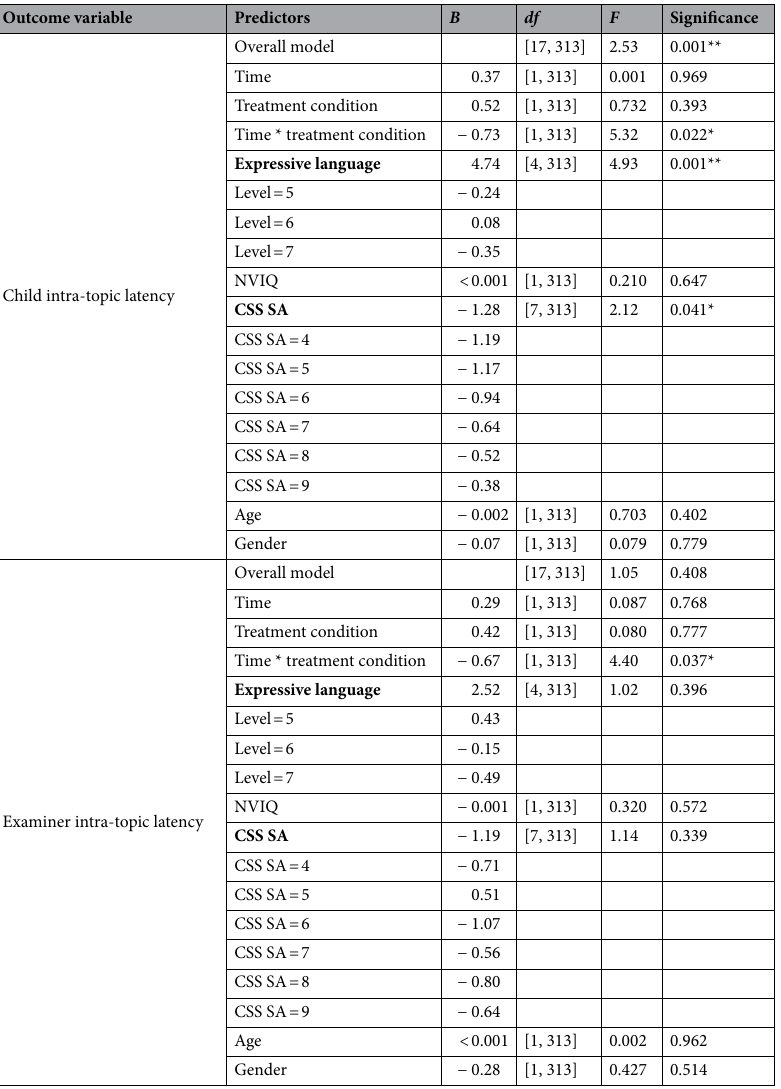
Table 2. Generalized linear mixed models of time and treatment effects for intra-topic latency. NVIQ nonverbal IQ, CSS SA calibrated severity score-social affect. * p < 0.05, ** p <